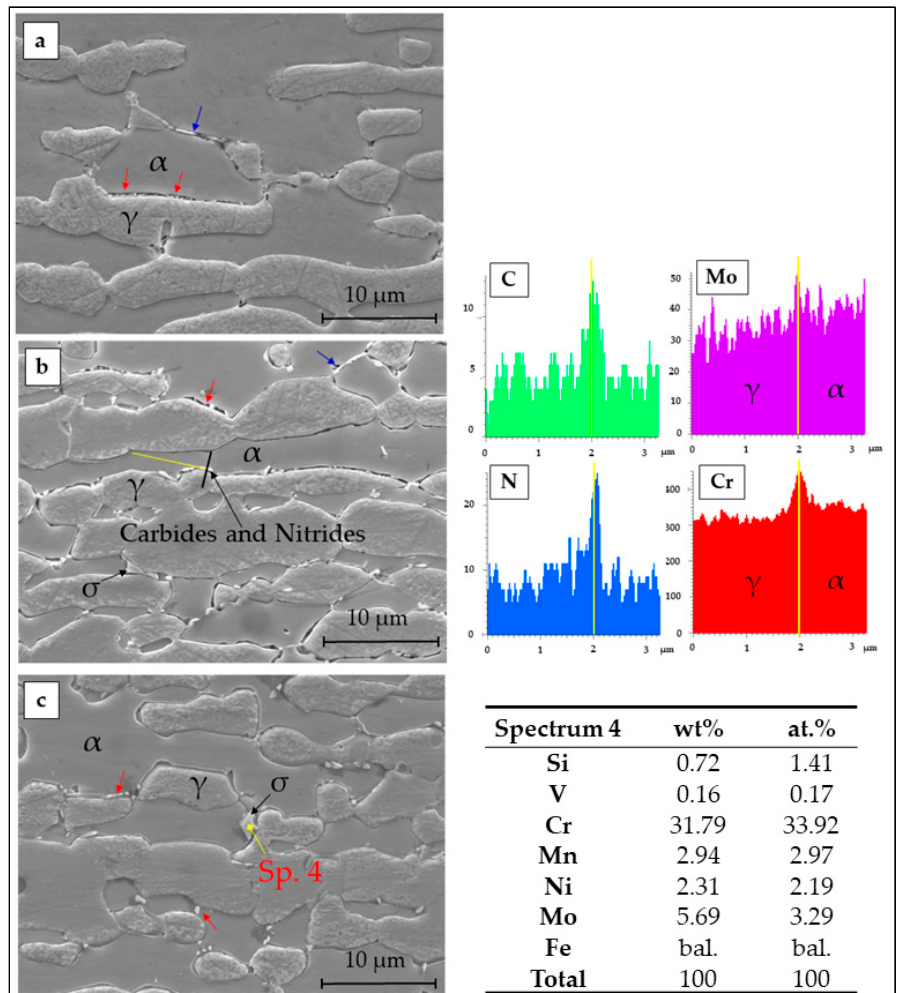
Figure 11. SEM (at secondary electrons) micrographs on LDSS 2404 electrodes aged 60 min at 650 ( a ), 750 ( b ), and 850 °C ( c ), after DL-EPR tests in 33 wt.% H 2 SO 4 solution, at 20 °C, with 0.9 wt.% HCl addition. EDS profile-line analysis (black segment through the particles at the α / γ interface in ( b )) related to chromium, nitrogen, molybdenum, and carbon elements.